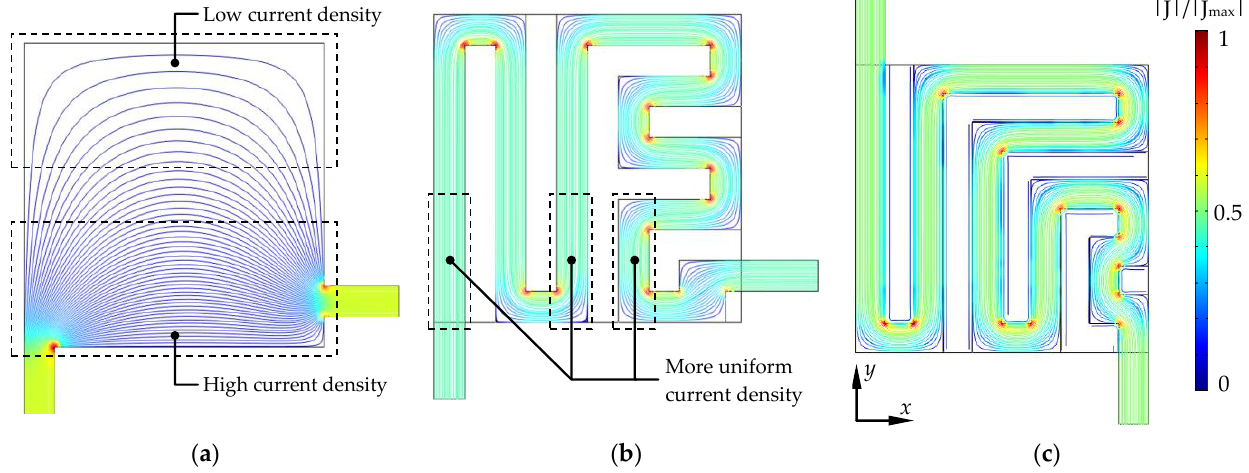
Figure 7. The relative current density distribution: ( a ) solid plate made of conductive PLA, ( b ) sensor with perpendicular contacts (Sensor 1) and ( c ) sensor with parallel contacts (Sensor 2).